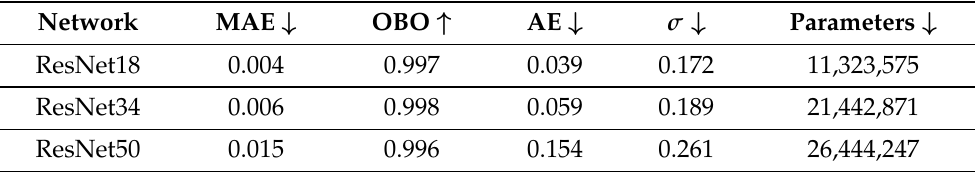
Table 4. Comparison of feature extraction networks for counting tasks. Four standards are displayed in this table: (MAE) Mean Average Error, OBO (Off-By-One), AE (Average Error) and σ (Stand Deviation), which are introduced in Section 4.2. This comparison is made under the premise that the exercise recognition backbone is ResNet34.